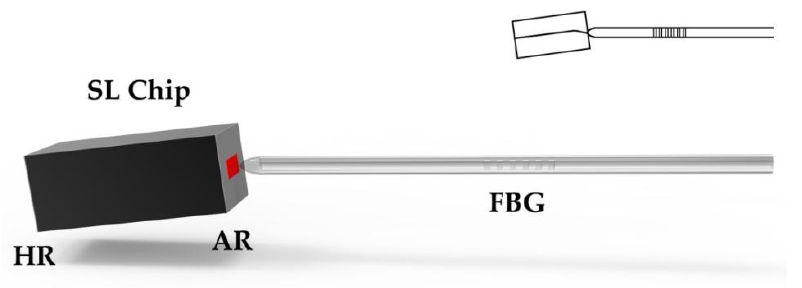
Figure 6. Structure of FBG-ECSL.